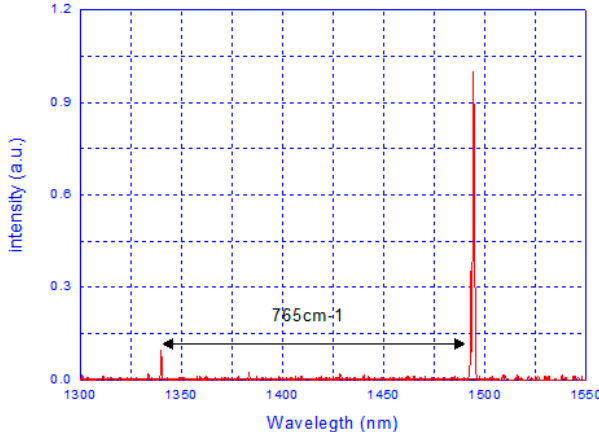
Figure 3. Optical spectrum of the actively Q-switched Nd:YVO 4 /RTP intracavity Raman laser.